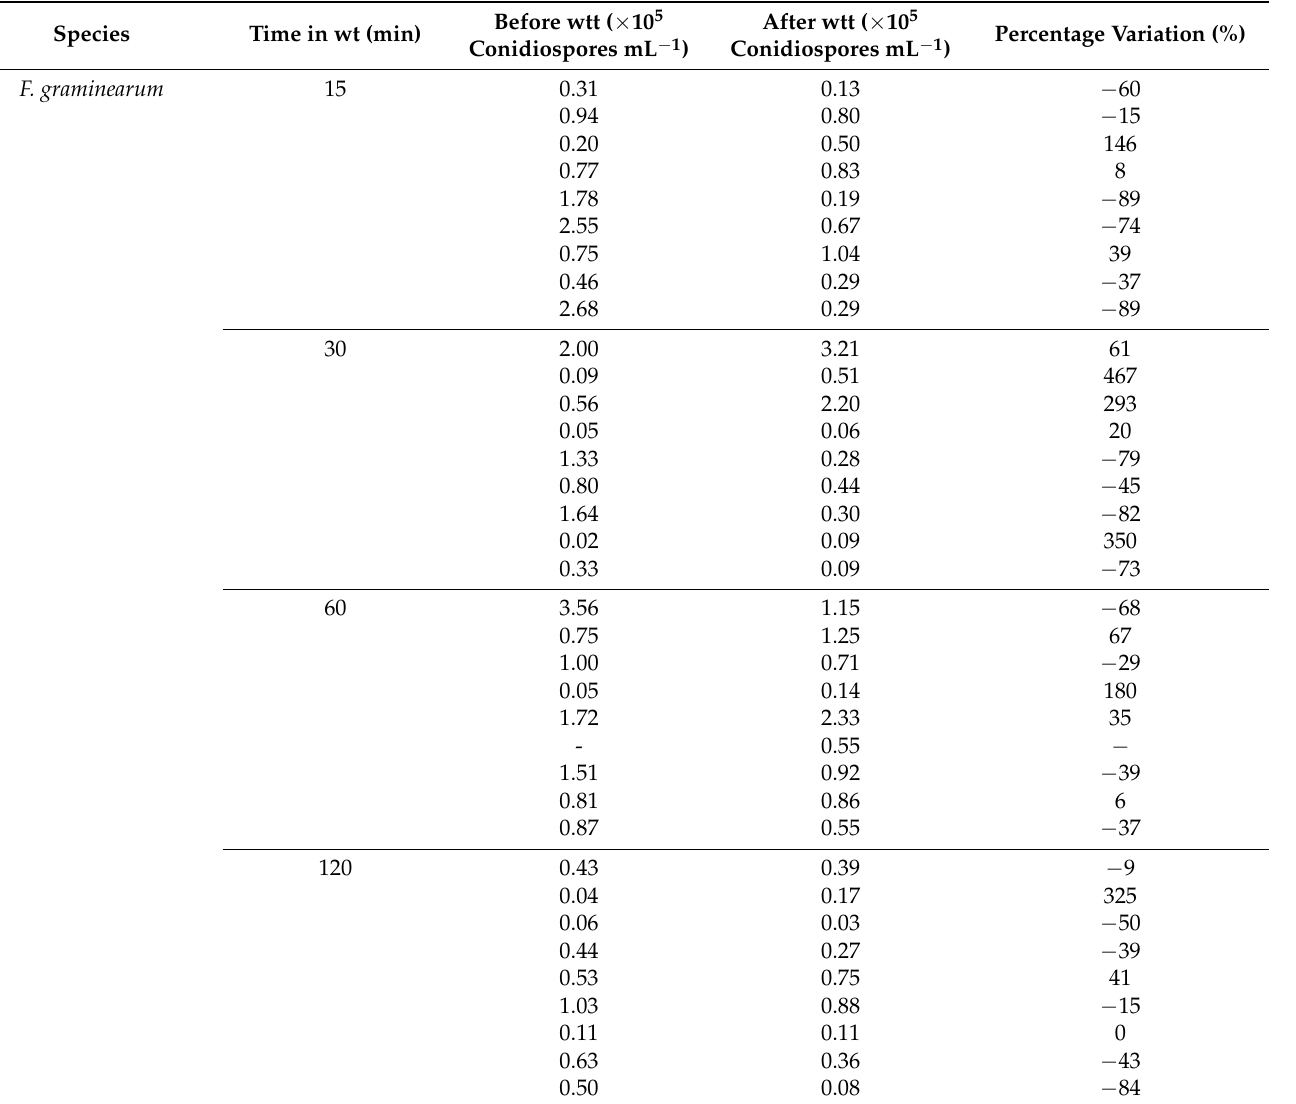
Table A1. Spore concentration on Fusarium -infected plates before and after wind tunnel treatment (wtt). This test was performed for F. graminearum and F. sporotrichioides for a period of 15, 30, 60, and 120 min in replicates of three. From three Petri Dishes containing the same species, half of the mycelium was taken initially to determine the spore concentration before the run using a Thoma counting chamber. Three half-covered Petri Dishes were placed in the wind tunnel (wt) with wind velocities of 5 m s − 1 . After 15, 30, 60, and 120 min, respectively, the plates were brought back to the laboratory to determine the spore concentration of the second half. Missing values were noted as “ −